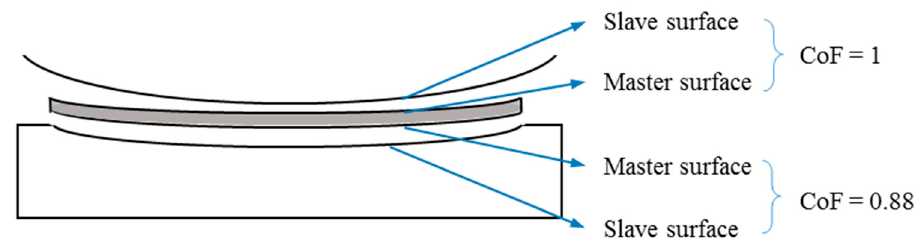
Figure 3. Contact interaction of the debris layer model.